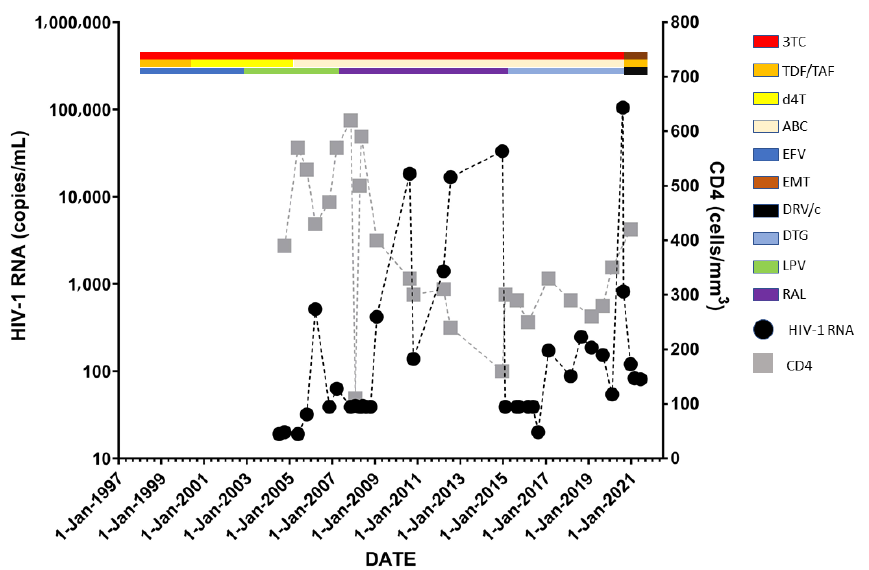
Figure 1. Treatment history and HIV status with HIV-1 RNA in copies/mL and CD4 cell counts in cells/mm 3 .